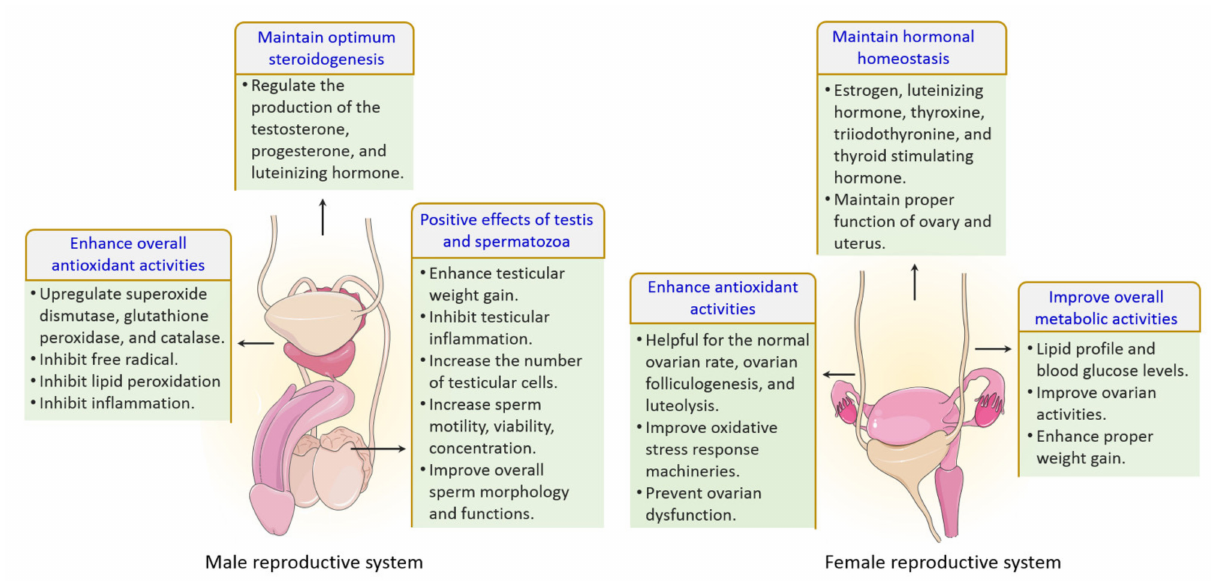
Figure 5. Hypothetical illustration showing black cumin action mechanism on reproduction. At the molecular level, black cumin exhibits its beneficial effects on reproduction via three major pathways: (1) adjust hormonal homeostasis, (2) enhance antioxidant capacity of reproductive tissue/cells, and (3) facilitate proper growth and maturation of germ cells and associated organs. A more detailed description of black cumin action can be found in the main